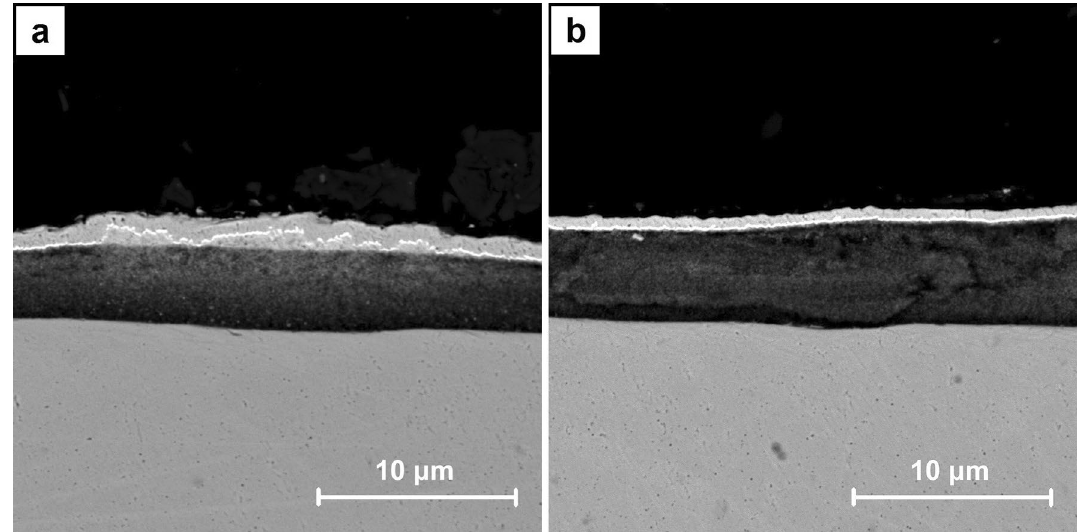
Figure 11. SEM images of the cross sections of A7 sample (ECD deposition time of 600 s, CuSO 4 concentration of 1 mM) at the magnification of